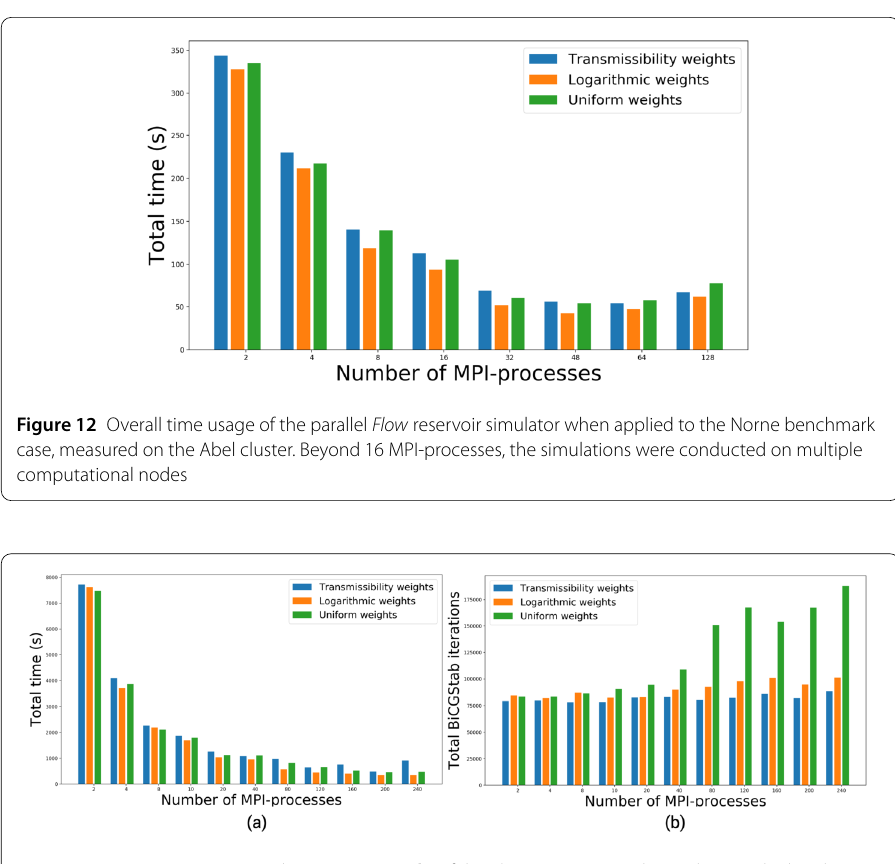
Figure 13 Execution time ( a ) and iteration count ( b ) of the Flow reservoir simulator when applied to the refined Norne benchmark case on the Saga cluster. Beyond 40 MPI-processes the simulations were conducted on multiple computational